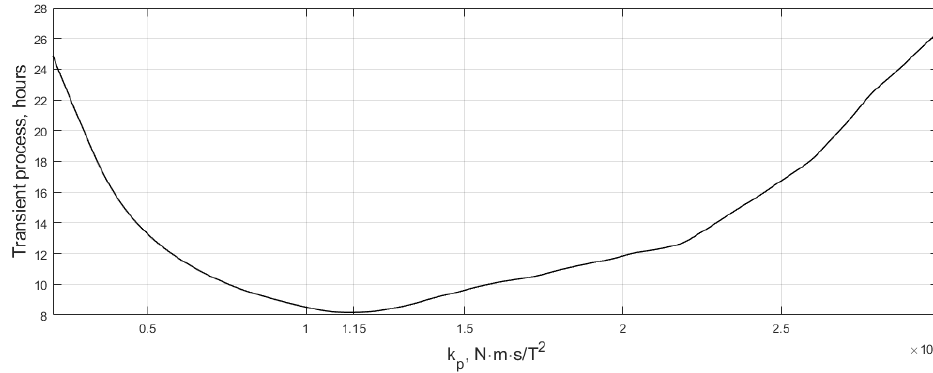
Figure 4. Transient process duration dependence on the positional control gain.